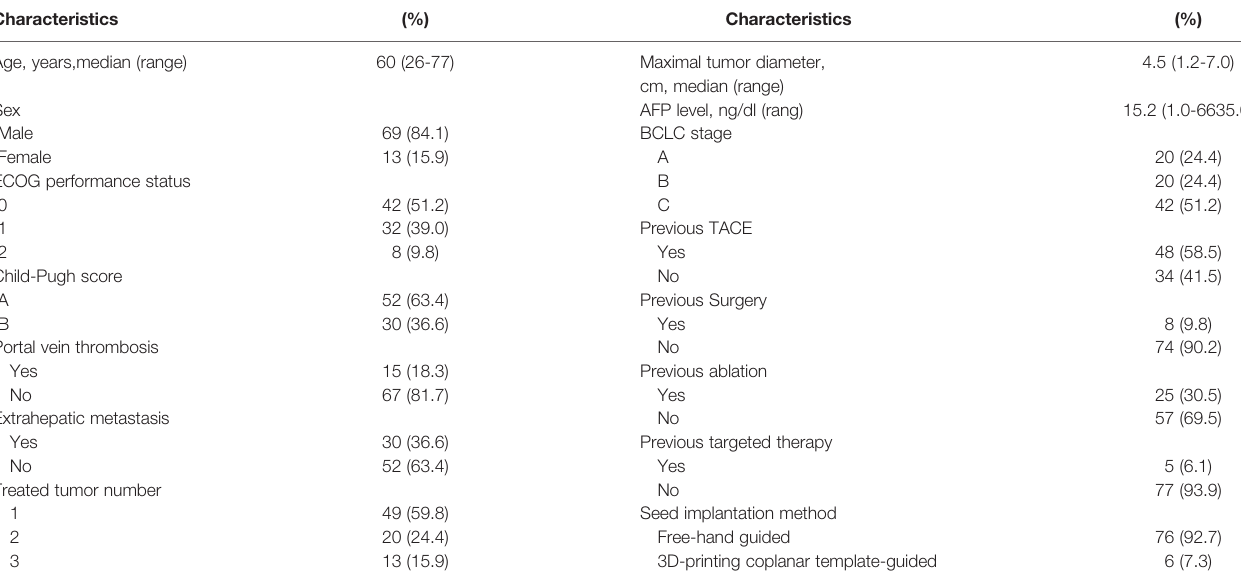
TABLE 1 | Patient and treatment characteristics